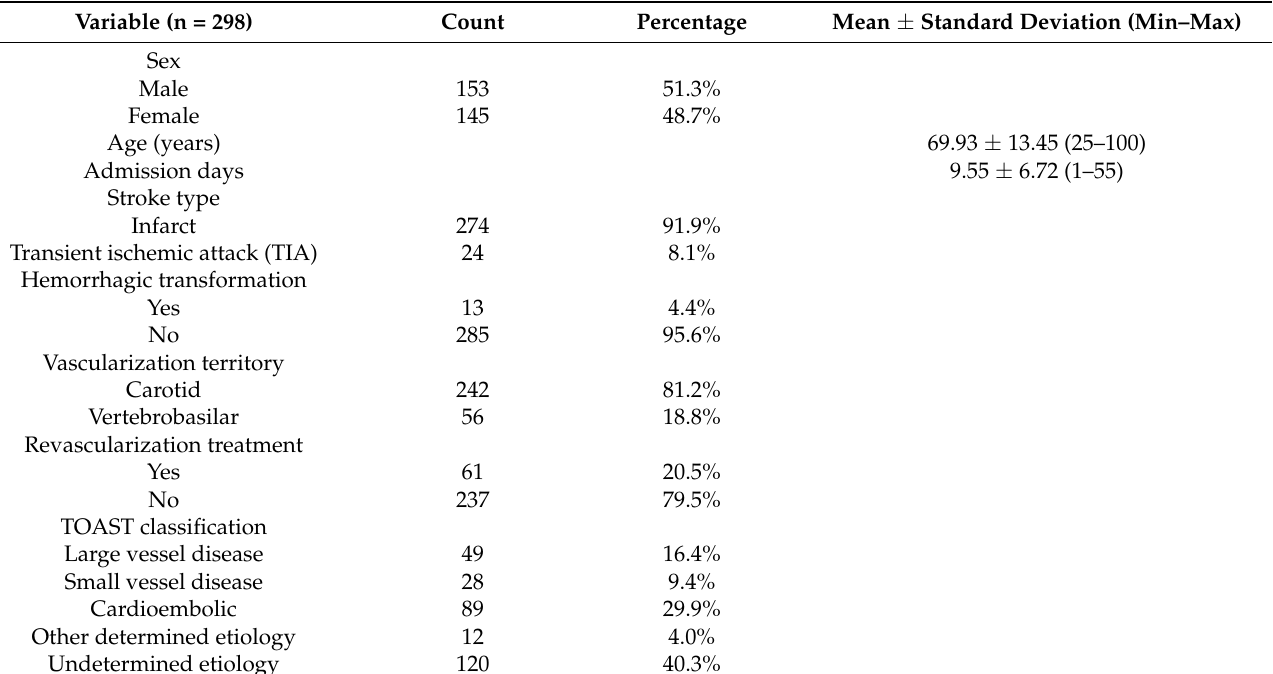
Table 1. Clinical and demographical characteristics.